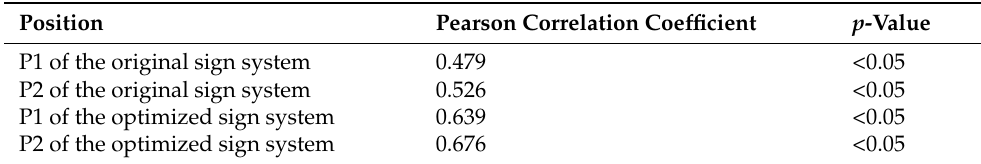
Table 1. Pearson correlation coefficient test of the trajectory spatial distribution between the VR experiments and the model simulations.